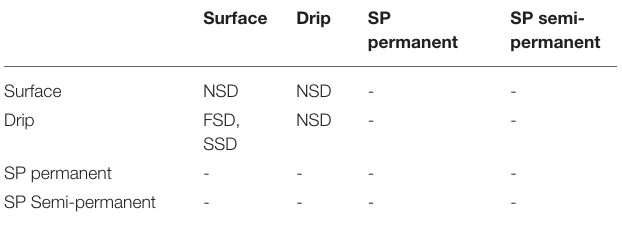
TABLE 7 | First- and second-degree stochastic dominance analysis for tomato